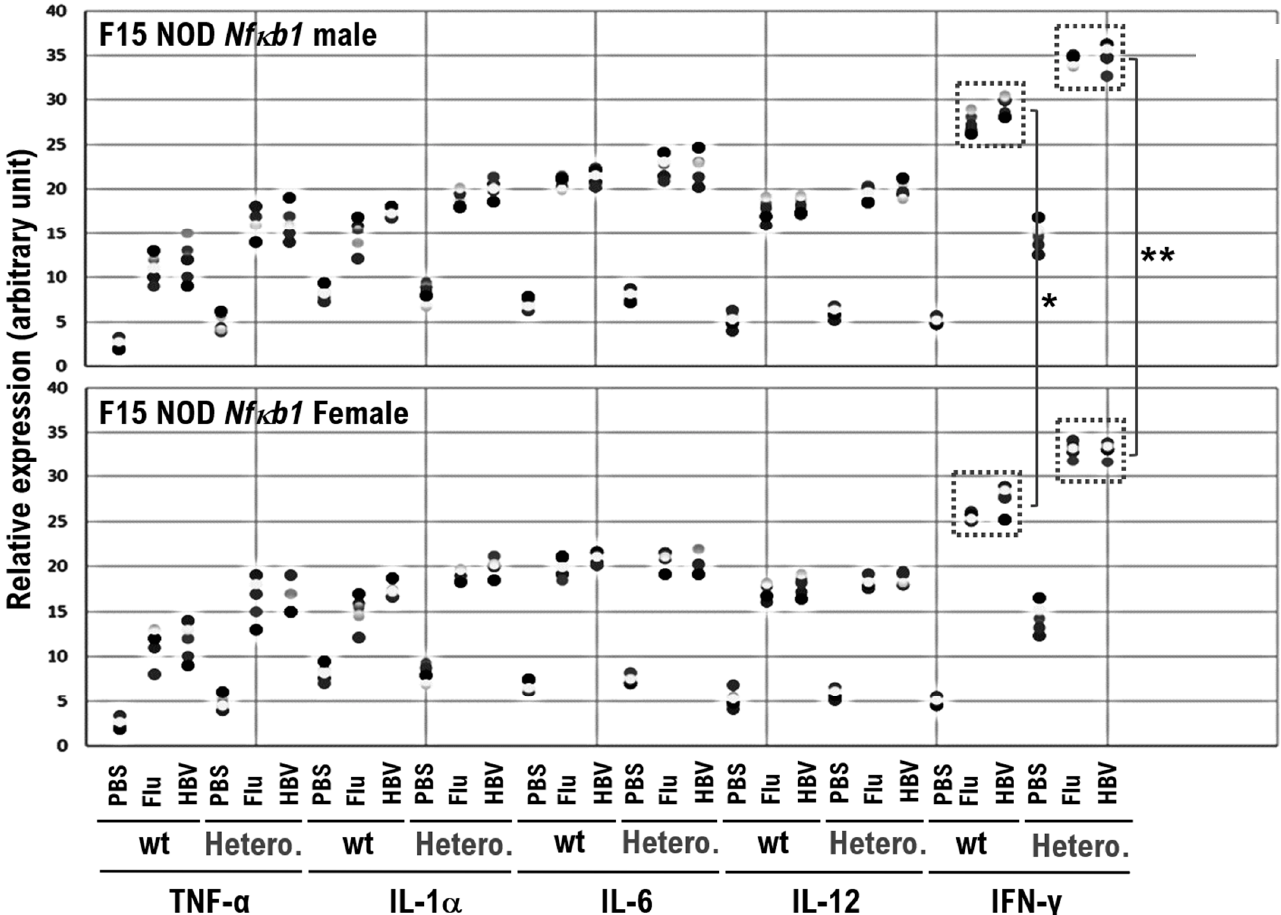
Figure 3. Elevated serum inflammatory cytokine levels in F15 NOD Nf κ b1 wild-type mice and F15 NOD Nf κ b1 heterozygote mice after vaccination with influenza HA or HBV (Bimmugen) vaccine. To collect serum for measuring serum inflammatory cytokine levels, mice were anesthetized with ether and bled retro-orbitally or alternatively 3 days after inoculation with 50 μ L of influenza HA or HBV (Bimmugen) vaccine, or PBS. The cytokine and chemokine levels in mouse serum (20 × dilution) were measured using the Mouse Cytokine Array Panel A (catalog no. ARY006; R&D Systems, Inc.) based on the manufacturer’s instructions. The serum inflammatory cytokine levels in male mice (upper panel) and female mice (lower panel) are shown. The serum inflammatory cytokine levels in F15 NOD Nf κ b1 wild-type and F15 NOD Nf κ b1 heterozygote mice after vaccination were significantly elevated 3 days after vaccination, but no elevation was observed in F15 NOD Nf κ b1 wild-type and F15 NOD Nf κ b1 heterozygote mice after intramuscular injection of PBS as a negative control. The levels of IFN- γ , an inflammatory cytokine that is markedly released from activated CD8-positive T-cells (also known as CTLs), were higher in male mice than in female mice. TNF- α , IL-1 α , IL-6, and IFN- γ are inflammatory cytokines that are regulated by the NF- κ B signaling cascade. The levels of all listed inflammatory cytokines are shown in Supplementary Figure S5. * p < 0.01, ** p < 0.005. Experiments were conducted with 5 animals in each group.